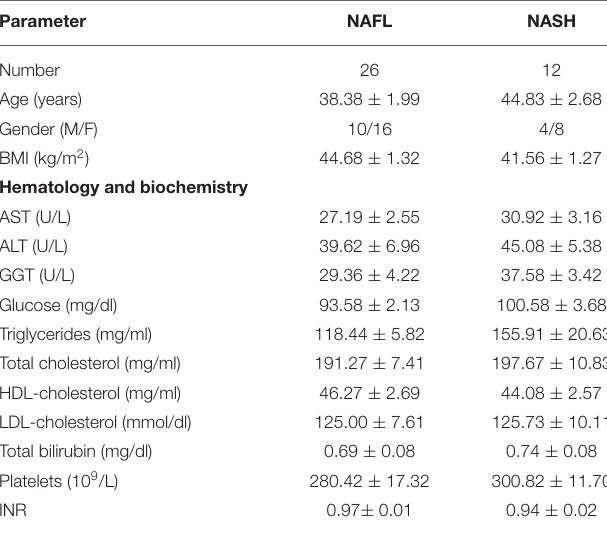
TABLE 1 | Patient demographic and clinical and laboratory data for the discovery cohort.